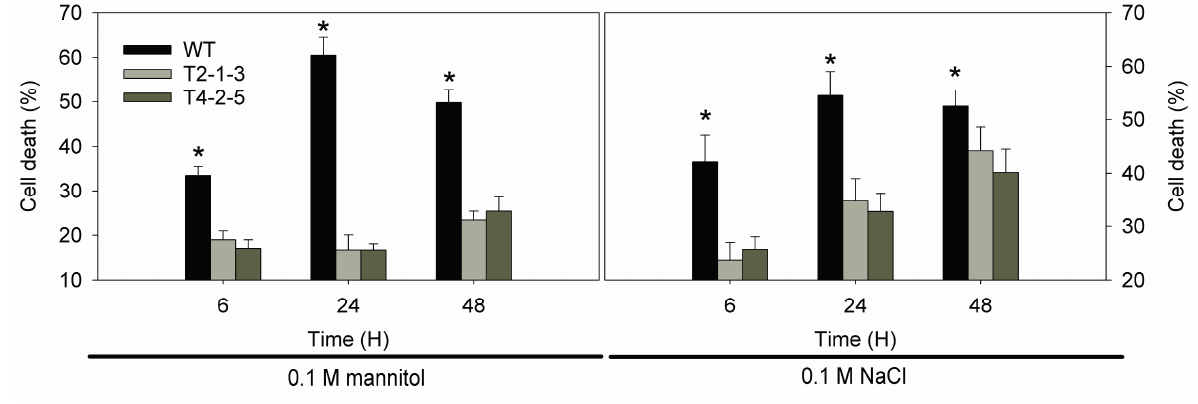
Figure 6. Cell death was determined by fluorescein diacetate (FDA) staining in the tobacco cell suspension induced by 0.1 M mannitol or NaCl for 6, 24 and 48 h. Results are the mean ± standard error (SE), replicated thrice. * indicates significant differences compared with the control at a p value